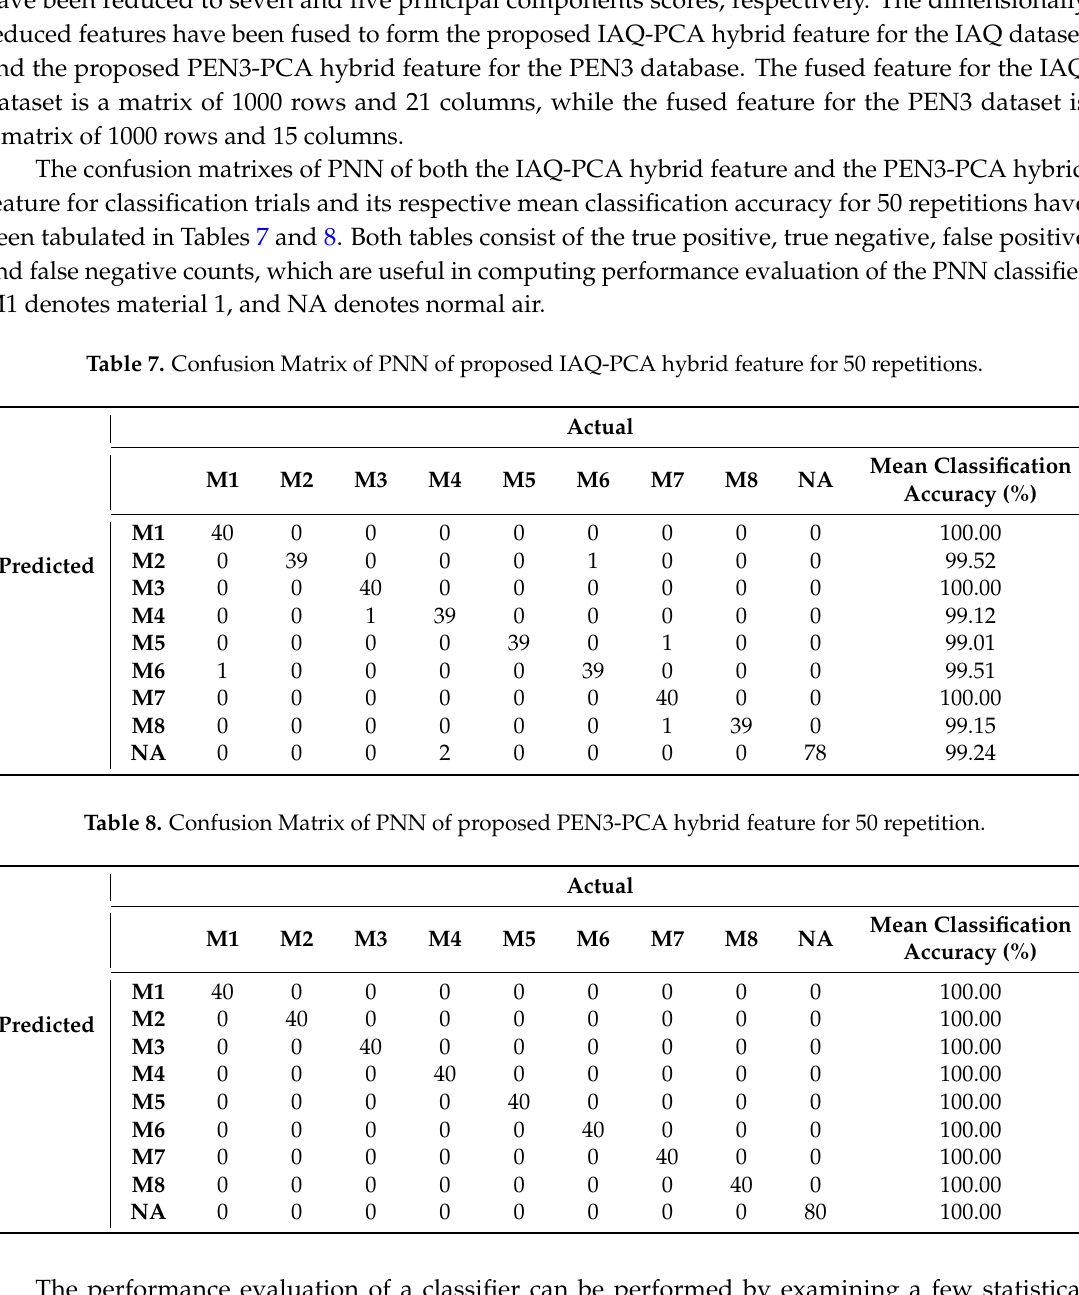
Table 7. Confusion Matrix of PNN of proposed IAQ-PCA hybrid feature for 50 repetitions.